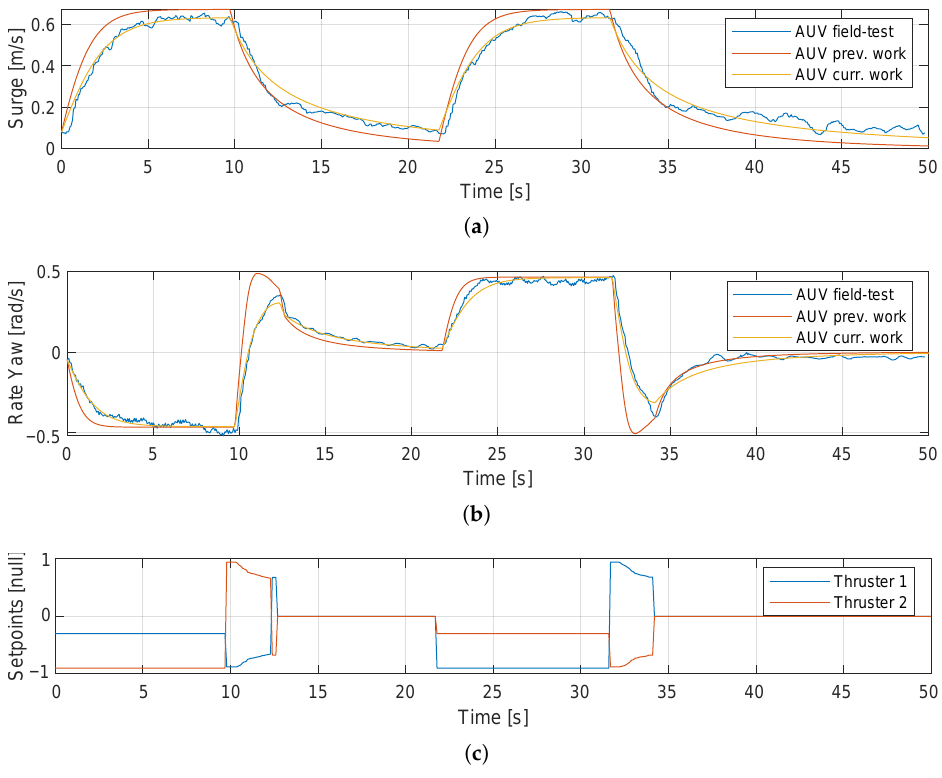
Figure 4. Comparison of previous work and the parameter estimation in the current work for the Girona500 in forwarding zig-zag motion: ( a ) Surge, ( b ) Yaw motion, ( c ) Thruster setpoints.